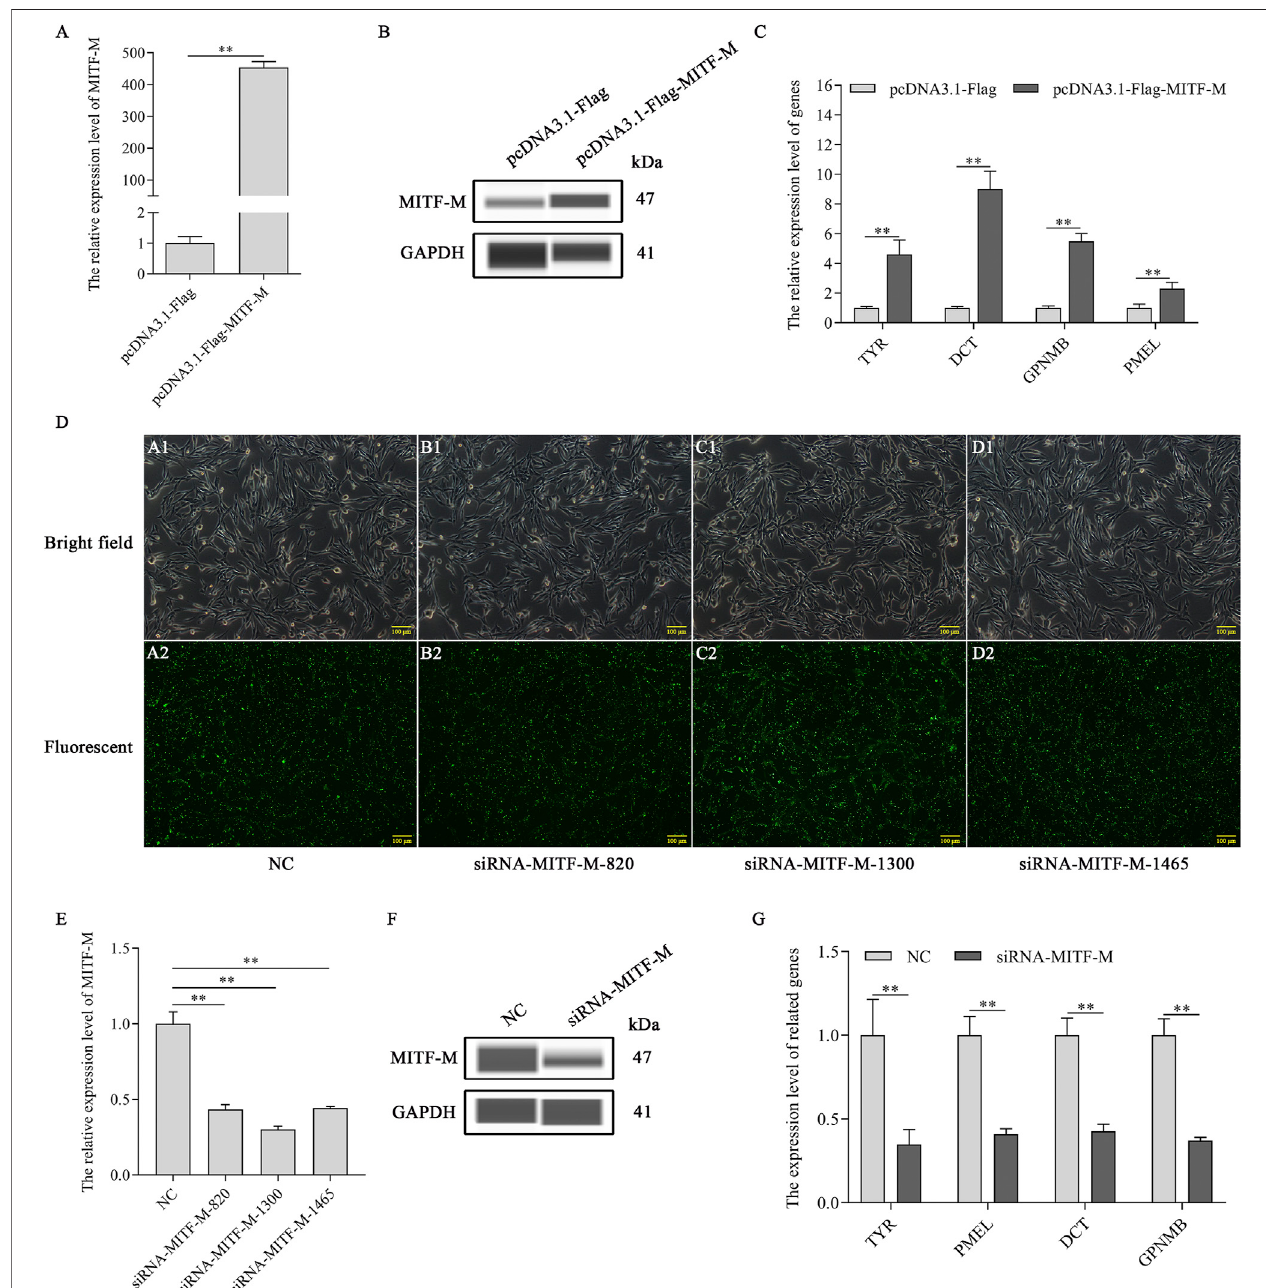
FIGURE2| MITF-M regulatedtheexpression ofthedownstreammelanin-relatedgenes. (A) MITF-M mRNA expression level,asper theqRT-PCRbasedanalysis, in MITF-M overexpressing melanocytes. (B) The MITF-M protein expression was determined by Wes in MITF-M overexpressing melanocytes. (C) The qRT-PCR assay was performed to detect the mRNA expression levels of melanin-related genes in MITF-M overexpressing melanocytes. (D) The MITF-M siRNAs containing 5 ′ FAM modi fi cation were transfected in melanocytes to determine its transfection ef fi ciency, and transfected cells were observed using fl uorescent inverted microscopy (100 × ). (E) The MITF-M mRNA expression was determined in MITF-M silenced melanocytes using qRT-PCR. (F) The MITF-M protein expression was determined in MITF-M silenced melanocytes using Wes. (G) The expression of melanin-related genes was determined after MITF-M downregulation in melanocytes using qRT-PCR. Each sample had three replicates, and the relative expression of genes was determined using GAPDH as an internal control by using the 2 − ΔΔ Ct method. ** indicates p < 0.01.